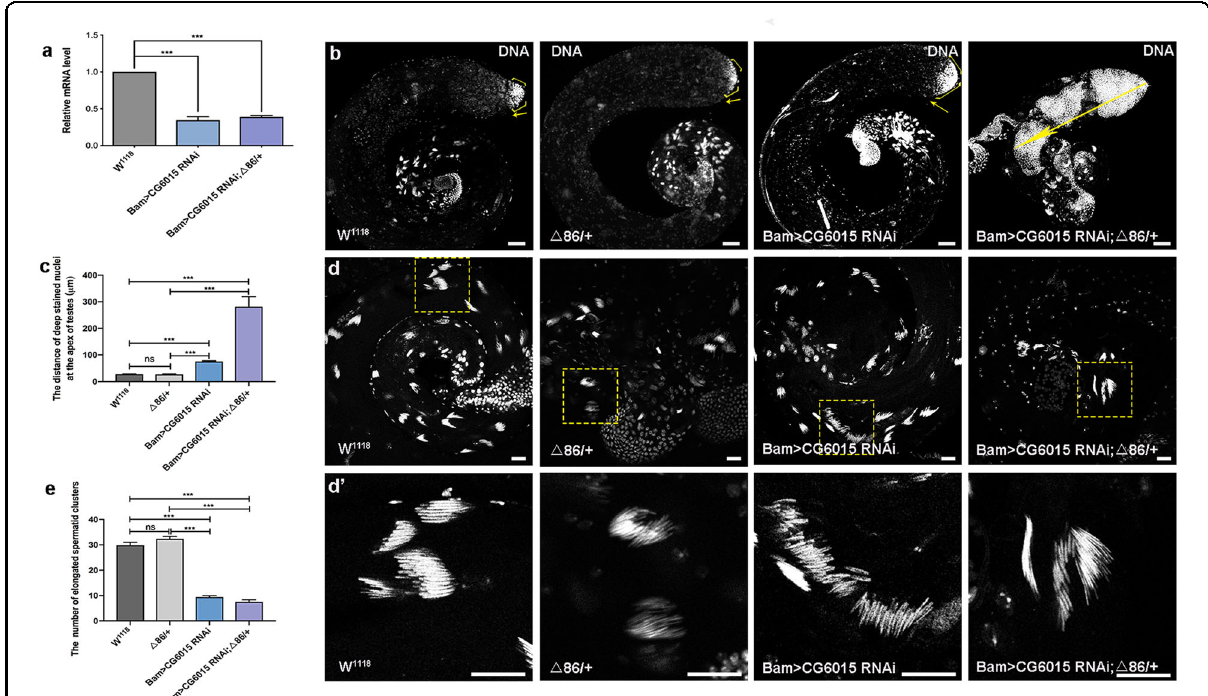
Fig. 1 Reduction of CG6015 in spermatogonia led to accumulation of undifferentiated cells and elongated spermatozoon defects. a Relative mRNA level of CG6015 in the W 1118 , Bam> CG6015 RNAi and Bam> CG6015 RNAi; Δ 86/ + testes. b Whole mount DNA staining of the W 1118 , Δ 86/ + , Bam> CG6015 RNAi and Bam> CG6015 RNAi; Δ 86/ + testes. Yellow arrows represent undifferentiated cells at the apex of the testis. c The distance of deep stained nuclei at the apex of W 1118 ( n = 50), Δ 86/ + ( n = 27), Bam> CG6015 RNAi ( n = 36) and Bam> CG6015 RNAi; Δ 86/ + ( n = 16) testes. d Elongated spermatid clusters at the tail of testes. d ’ Enlargements of corresponding elongated spermatid clusters. e The number of elongated spermatid clusters in W 1118 ( n = 44), Δ 86/ + ( n = 25), Bam> CG6015 RNAi ( n = 33) and Bam> CG6015 RNAi; Δ 86/ + ( n = 10) testes. DNA was stained with Hoechst (blue). *** P < 0.001, ns. not signi fi cant. Scale bar: 50 μ m for b ; 20 μ m for d and d ’